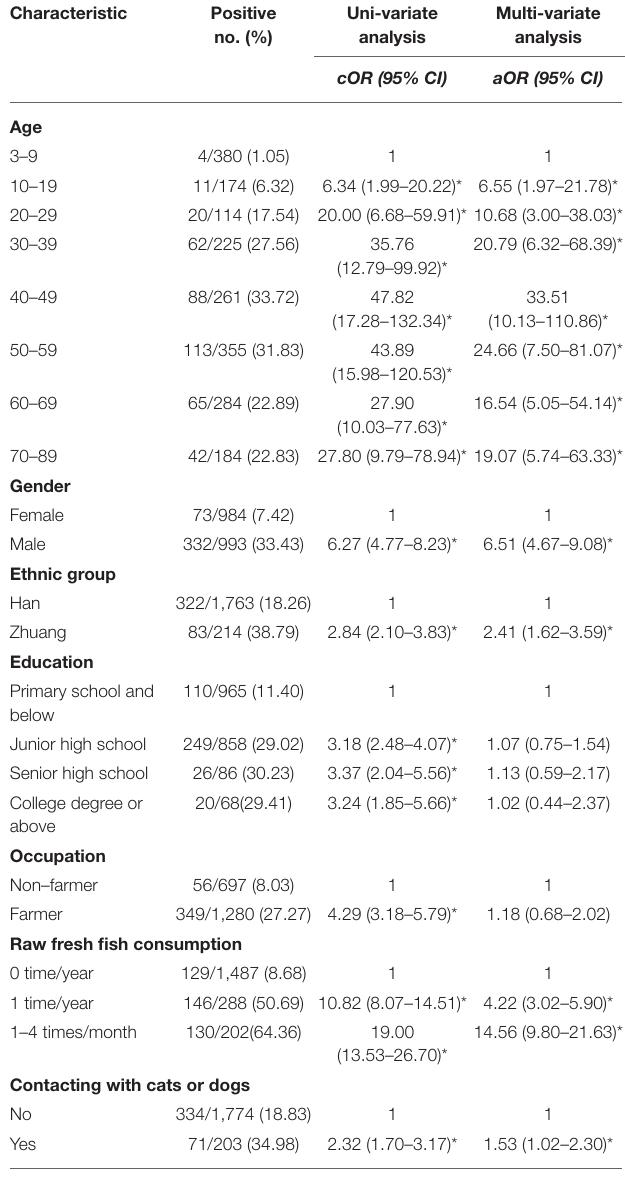
TABLE 2 | Uni-variate and multi-variate analysis of risk factors associated with C. sinensis infection in Binyang, Guangxi ( n = 1,977). Characteristic Positive Uni-variate Multi-variate no. (%) analysis